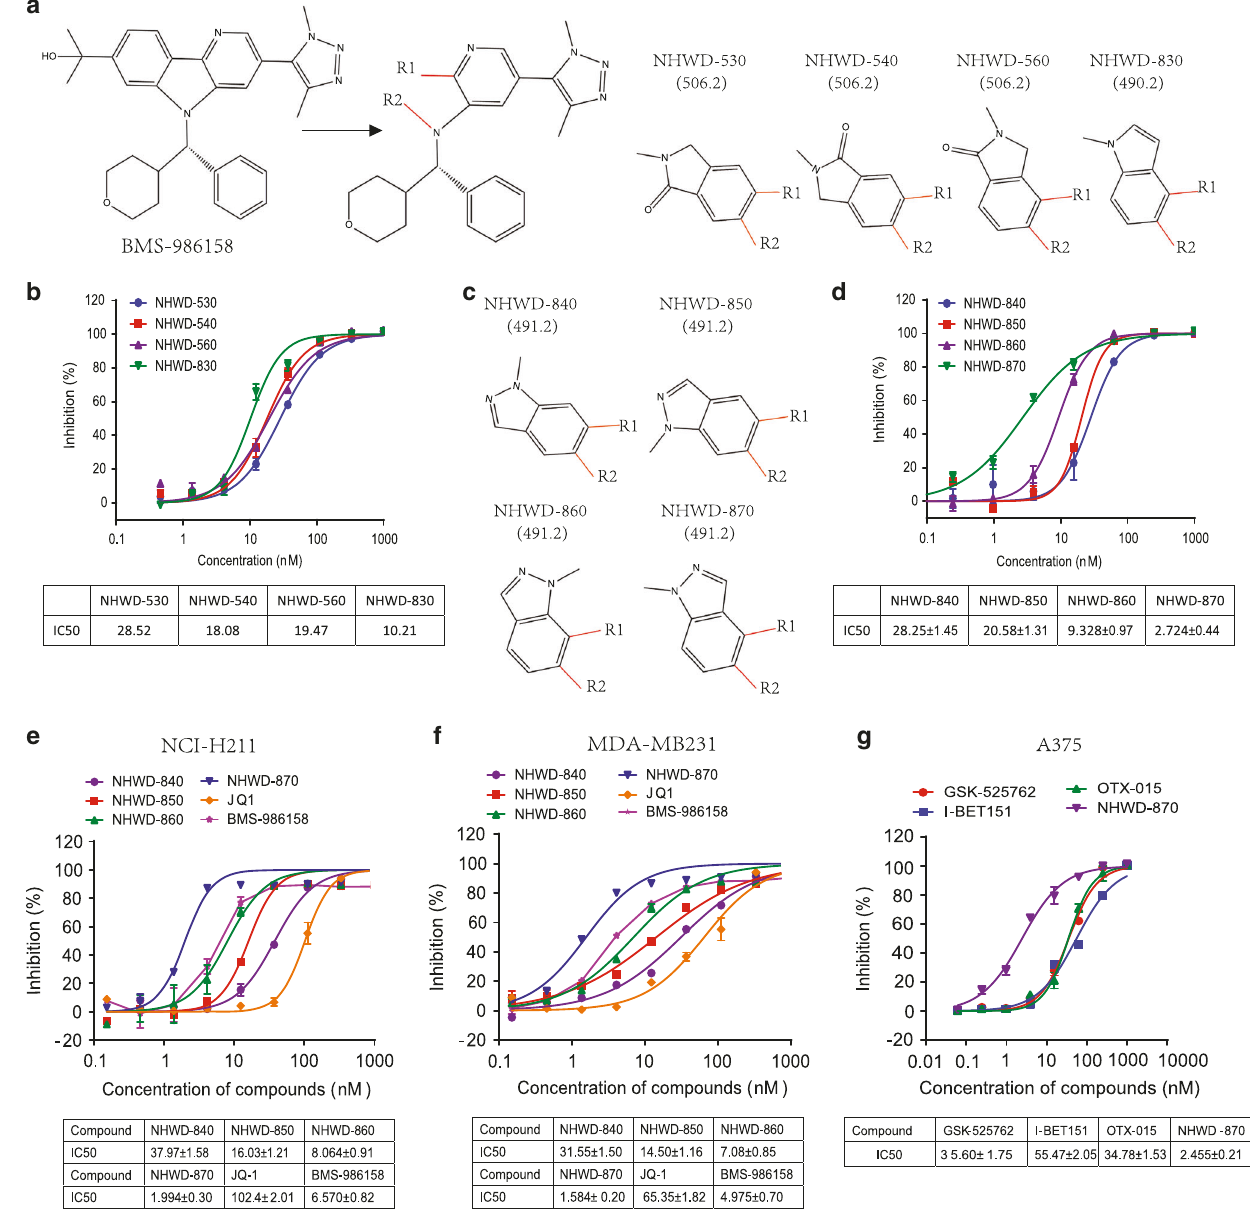
Fig. 1 Rational design of a potent BET inhibitor NHWD-870. a Chemical structure of BET inhibitor BMS-986158 and its analogs NHWD-530, NHWD- 540, NHWD-560, and NHWD-830. b Biochemical activity of NHWD-530, NHWD-540, NHWD-560, and NHWD-830 against BRD4 (BD1 + BD2). The bottom panel shows the average IC 50 values for these compounds. c Chemical structures of NHWD-830 analogs NHWD-840, NHWD-850, NHWD-860, and NHWD-870. d Biochemical activity of NHWD-840, NHWD-850, NHWD-860, and NHWD-870 against BRD4 (BD1 + BD2). Bottom panel shows the average IC 50 values for these compounds. e , f Cellular activities of NHWD-840, NHWD-850, NHWD-860, NHWD-870, JQ-1, and BMS-986158 in SCLCs (H211) ( e ) and TNBCs (MDA-MB231) ( f ), as measured by alamarBlue assays. Bottom panels show the average IC50 values for these compounds. g Cellular activities of GSK-525762, I-BET151, OTX-015, and NHWD-870 in melanoma cells (A375), as measured by alamarBlue assays. The bottom panels show the average IC50 values for these compounds. Three independent experiments were performed for all experiments. Data are plotted as mean ± SEM from two independent experiments. Source data are provided as a Source Data fi